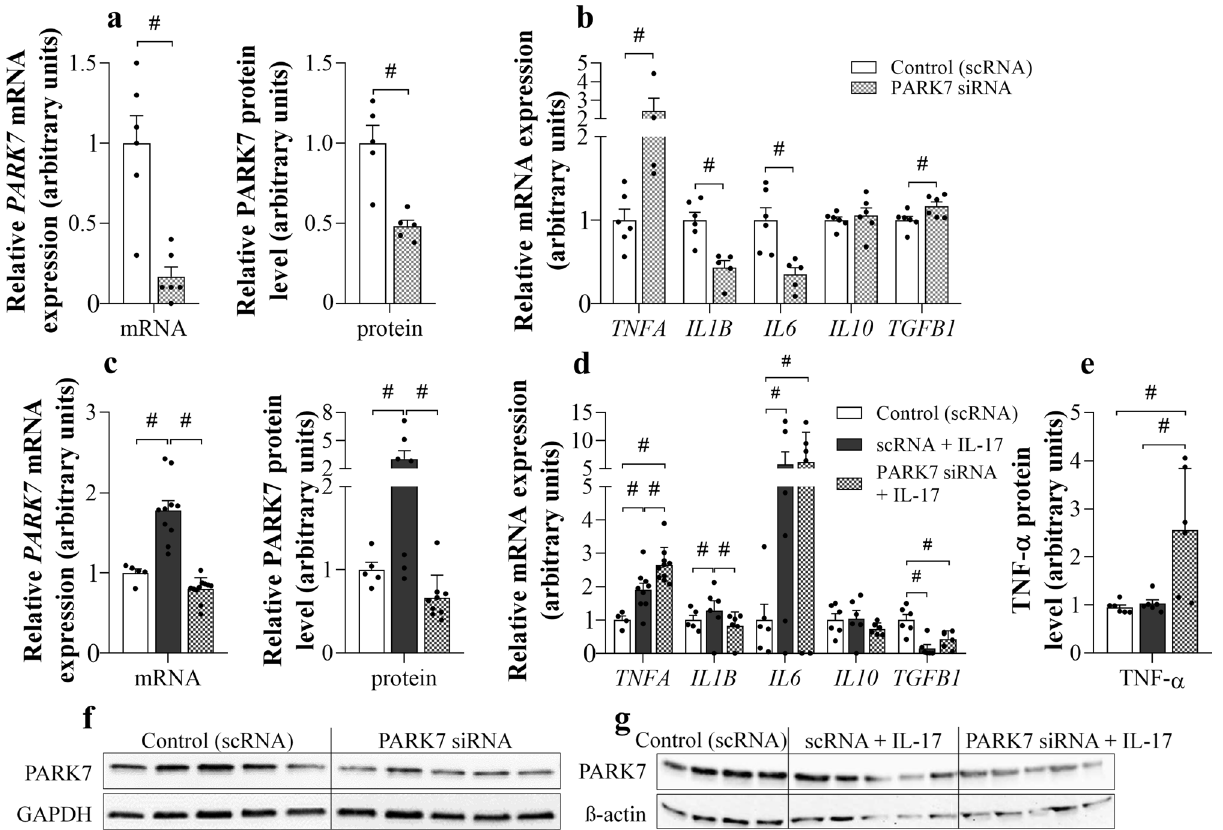
Figure 4. Effect of PARK7 silencing on TNFA , IL1B, IL6, IL10 and TGFB1 expression of HT-29 cells. Cells were transfected either with scRNA or PARK7 specific siRNA ( a – g ) and a group of transfected cells was also treated with IL-17 ( c – e , g ). The mRNA expression of PARK7, TNFΑ, IL1Β, IL6, IL10 and TGFB1 was determined by real-time PCR ( a – d ), and the protein level of PARK7 ( a , c , f , g ) and TNF-α ( e ) by Western blot ( a , c , f , g ) or ELISA ( e ), respectively (n = 4–6). Relative expression levels are presented in comparison with Gapdh mRNA ( a – d ), GAPDH ( a , f ) or ß-actin protein ( c , g ) as internal control and normalized to vehicle treated group. Results are illustrated as mean + SEM, dots represent individual values. Analysis of significance was performed by Mann–Whitney or Kruskal–Wallis test. # p < 0.05 comparing the connected groups. Full-length blots are included in “Supplementary